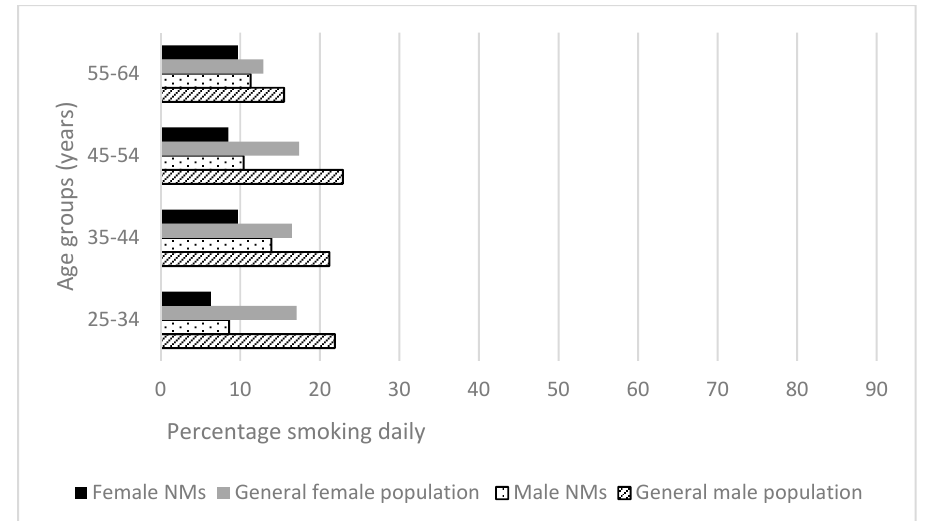
Figure 7. Health-related behaviors of nurses and midwives compared to the Australian general population 2014–2015 [30]: Smoking.